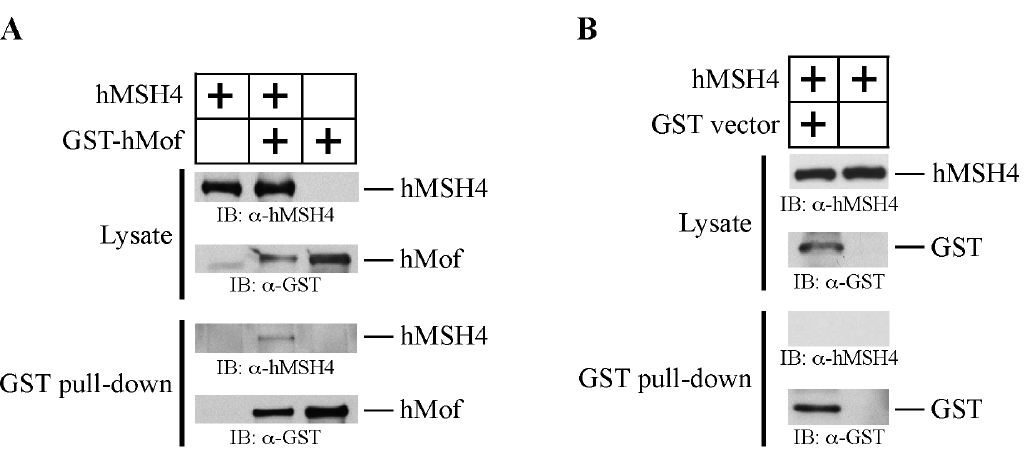
Figure 2. hMSH4 interacts with hMof. ( A ) Recombinant hMof was produced as a glutathione S -transferase-tagged fusion protein and was co-expressed with hMSH4. Soluble cell lysates were used for GST pull-down analysis. Western blot analysis was performed to detect the expression of hMSH4 protein; (B) Negative controls for GST pull-down assay. In the absence of GST-hMof, glutathione-Sepharose 4B beads could not directly pull down hMSH4 even in the presence of GST tag; ( C ) Co-immunoprecipitation analysis of hMSH4 and hMof interaction in human cells. Myc-hMSH4 and Flag-hMof expression in 293T cells was validated by Western blotting. IR treatment was performed 48 h after transfection. The α -Flag antibody was used to perform co-immunoprecipitation analysis, and co-immunoprecipitated hMSH4 was validated by Western blot